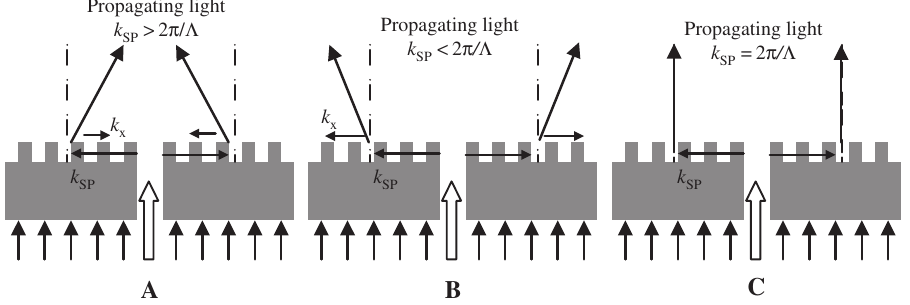
> 2 π / Λ , (B) k < 2 π / Λ , and SP SP